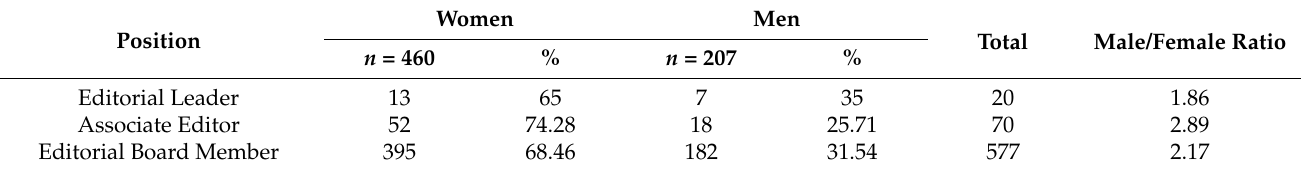
Table 5. Gender analysis of different editorial board member positions.